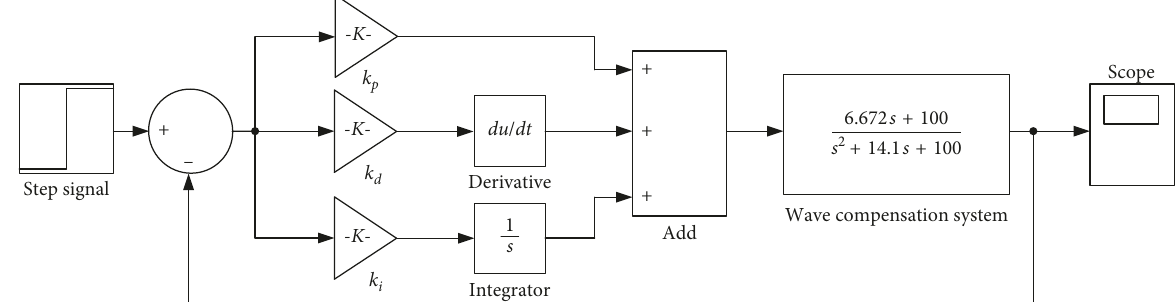
Figure 12: The wave compensation PID control system after the pole